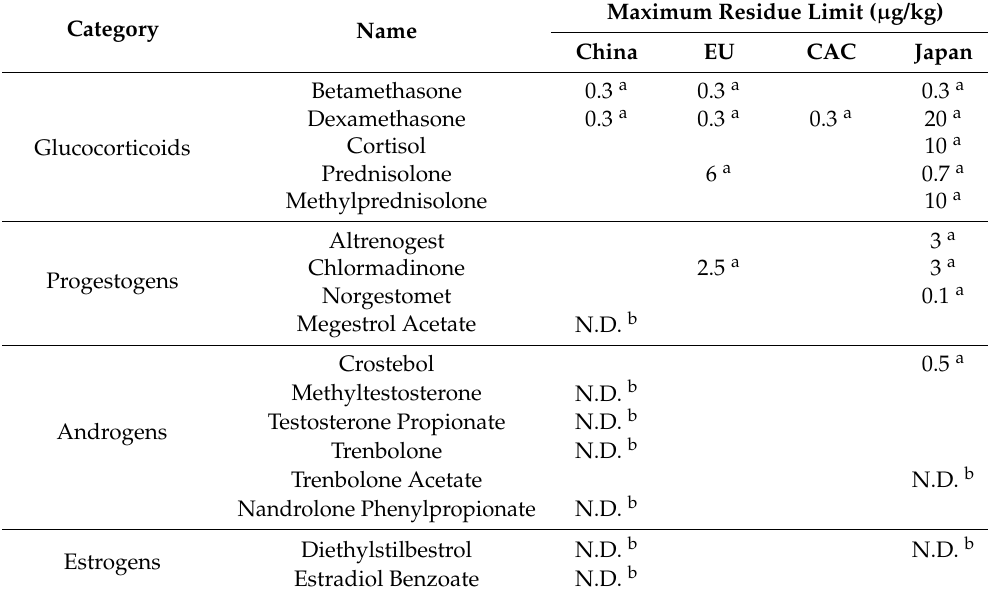
Table 4. The maximum residue limit for hormones in raw milk in China, the European Union (EU), the Codex Alimentarius Commission (CAC), and